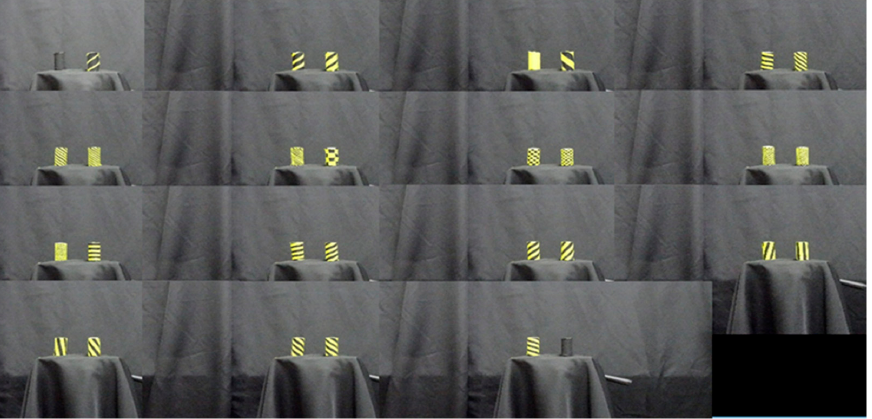
Figure 3. Evaluation samples. A total of 29 different patterns.